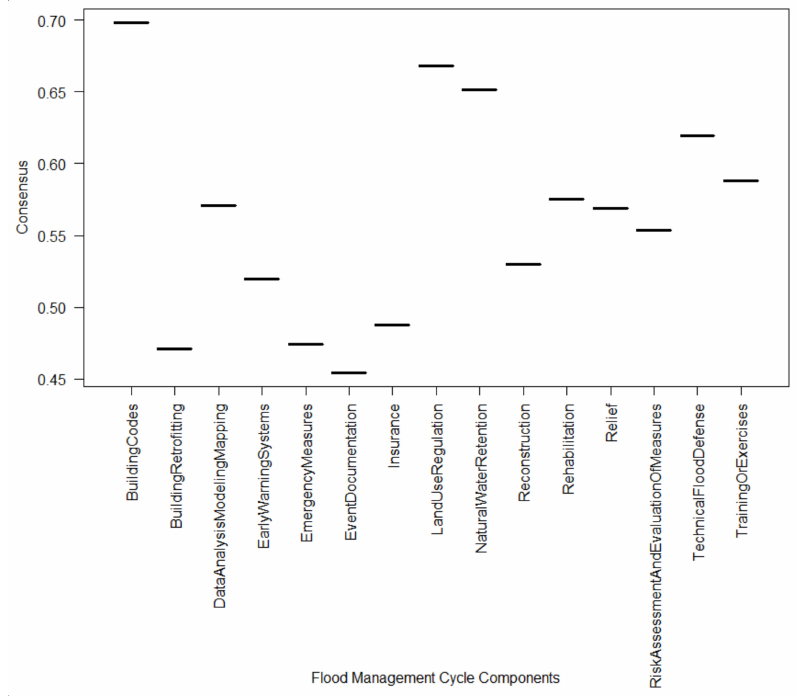
Figure A8. Agreement (consensus) among survey participants of the prioritization of flood manage- ment phases (components) to rural mountain areas (the higher value, the more homogeneous the given responses; scale from 0 to